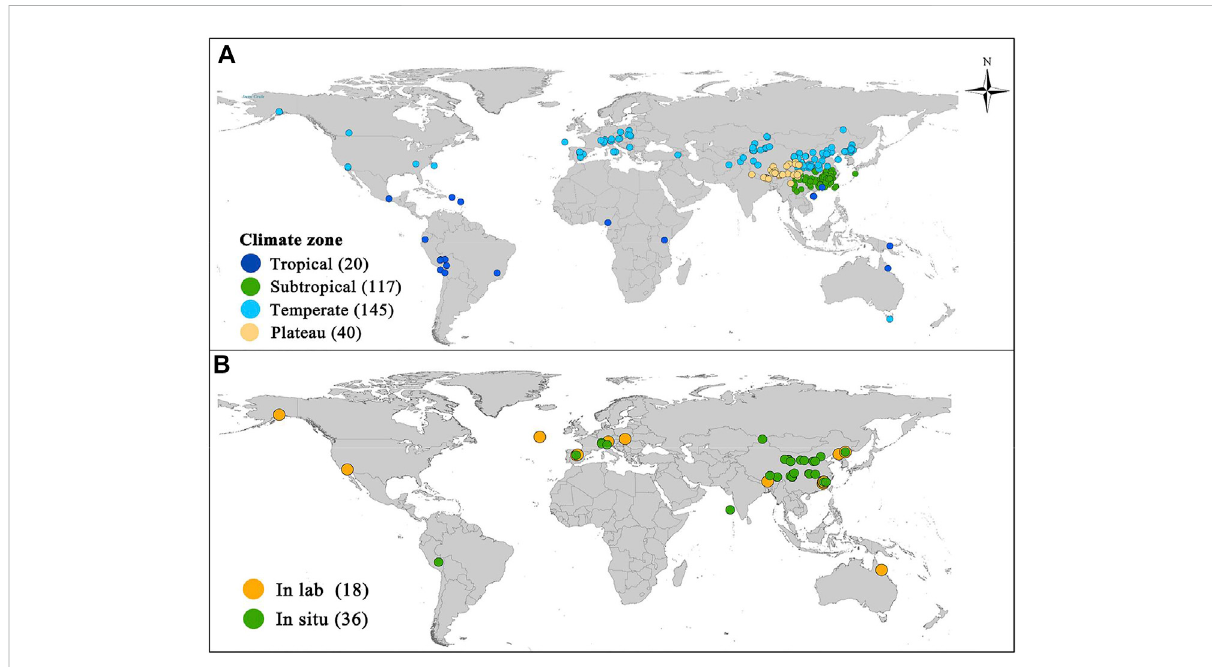
0.90 to 5.74 (mean 2.76) with an altitudinal gradient (Supplementary Figure S2A). We also did not observe a signi fi cant relationship between Q 10 values and altitude in in situ studies on a global scale ( p > 0.05; Supplementary Figure S2B), but the Q 10 in different climate zones was signi fi